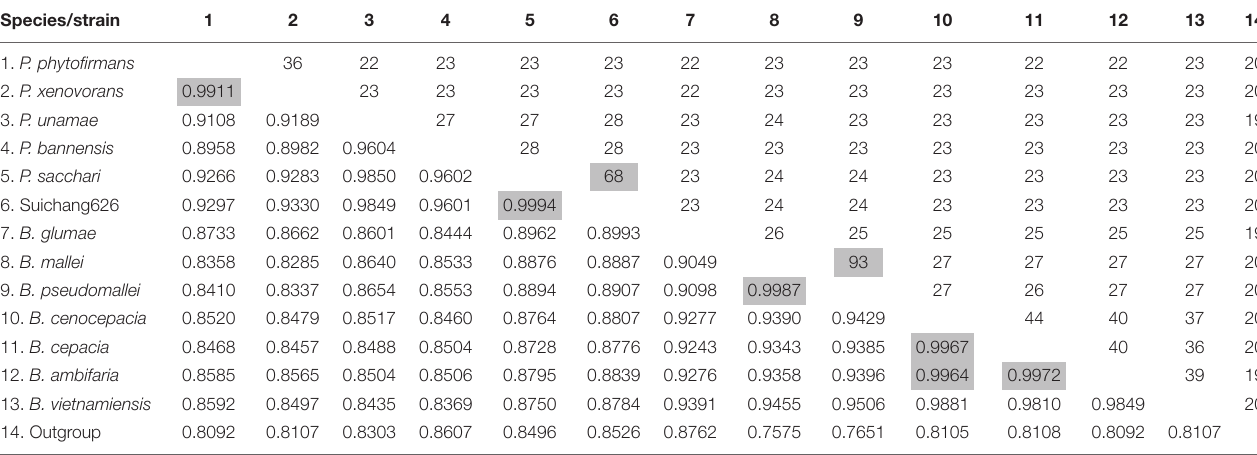
TABLE 3 | The digital DNA-DNA hybridization (dDDH) values and tetranucleotide frequency correlation coefficient (TETRA) of selected Paraburkholderia and Burkholderia genomes.